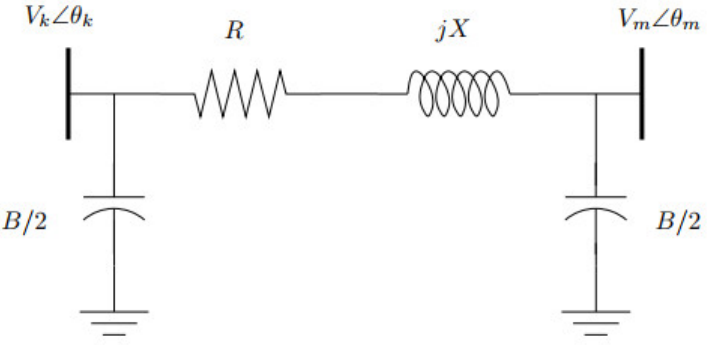
Figure 9. π equivalent circuit of the transmission line. Figure 9.  equivalent circuit of the transmission line.